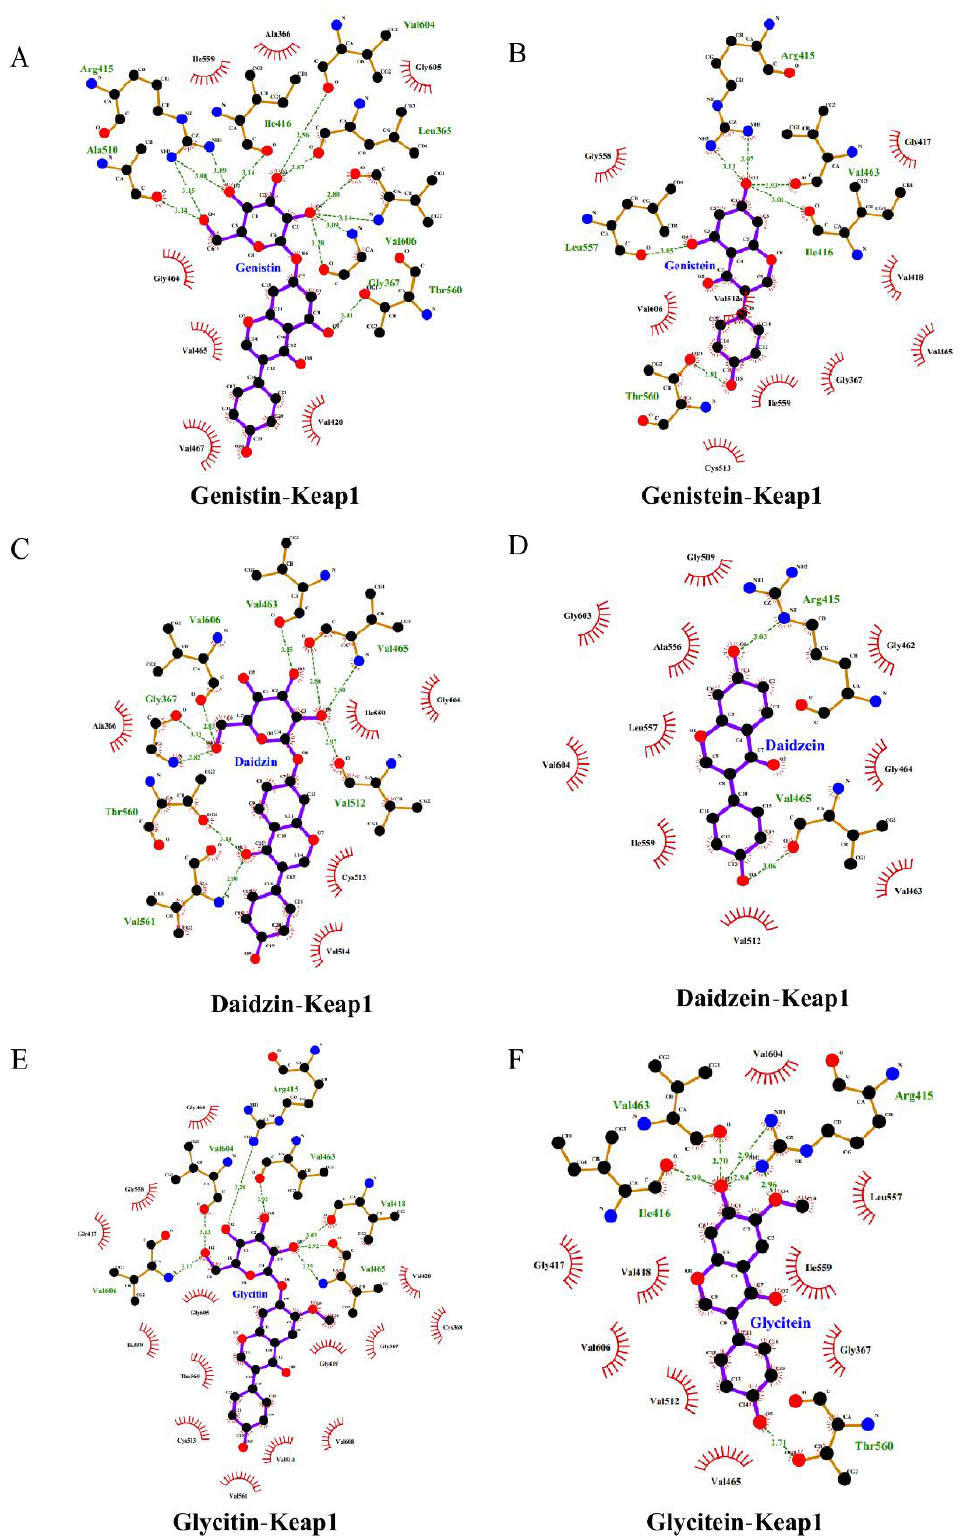
Figure 6. Molecular docking analysis of the interactions between isoflavones and Keap1 protein (2D diagram). (A) G en istin bound to keap1. (B) G en istein bound to keap1. (C) Daidzin bound to keap1. (D) Daidzein bound to keap1. (E) G lyci tin bound to keap1. (F) G lyci tein bound to keap1. Table 1. Details of the docked complex of Keap1 with isoflavones.